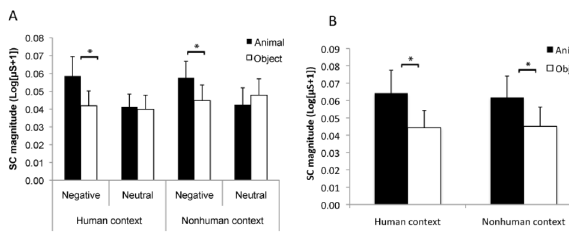
Figure 5. The results of Experiment 3. Nonhuman animals elicited stronger responses in SC magnitude than inanimate objects in the negative condition (A). The animate advantage in SC responses was also shown regardless of human context when the pictures of snakes, spiders and sharks were compared to those of guns (B). Error bars represent standard errors of the